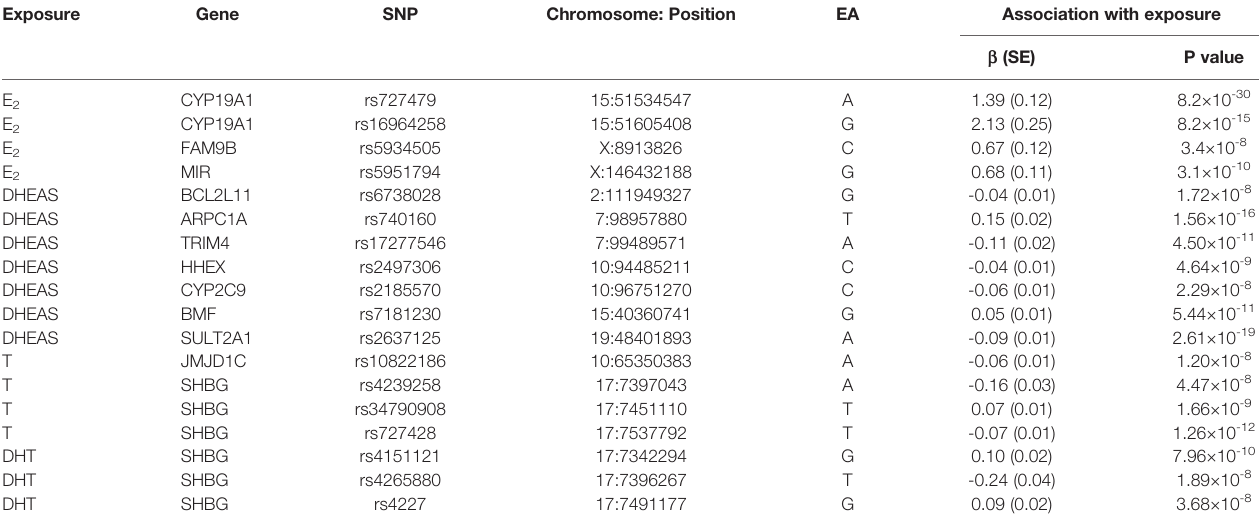
TABLE 1 | Characteristics of SNPs for exposures from